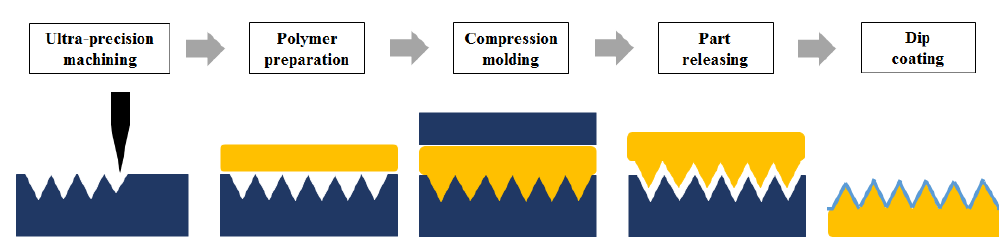
Figure 2. Schematic image of the fabrication procedure.